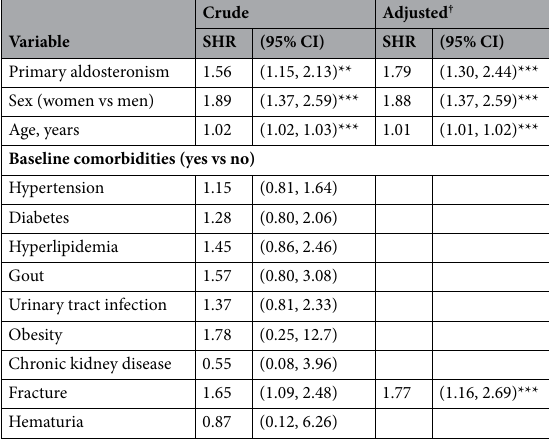
Table 3. SHR and 95% CI of bladder stones in association with sex, age, and comorbidities in univariable and multivariable competing risk (death) model. Crude SHR represents a relative sub-hazard ratio. CI confidence interval, SHR sub-hazard ratio. † The multivariable models included all statistically significant risk factors in the univariable competing risk (death) model. * P < .05, ** P < .01, *** P <